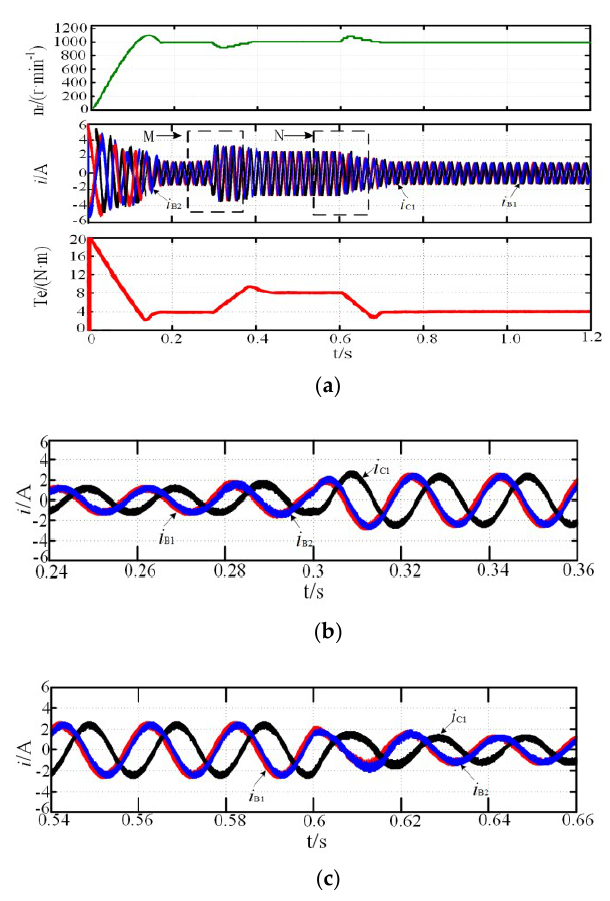
Figure 3. Start-up process simulation: ( a ) normal; ( b ) magnification of M region; ( c ) magnification of N region.